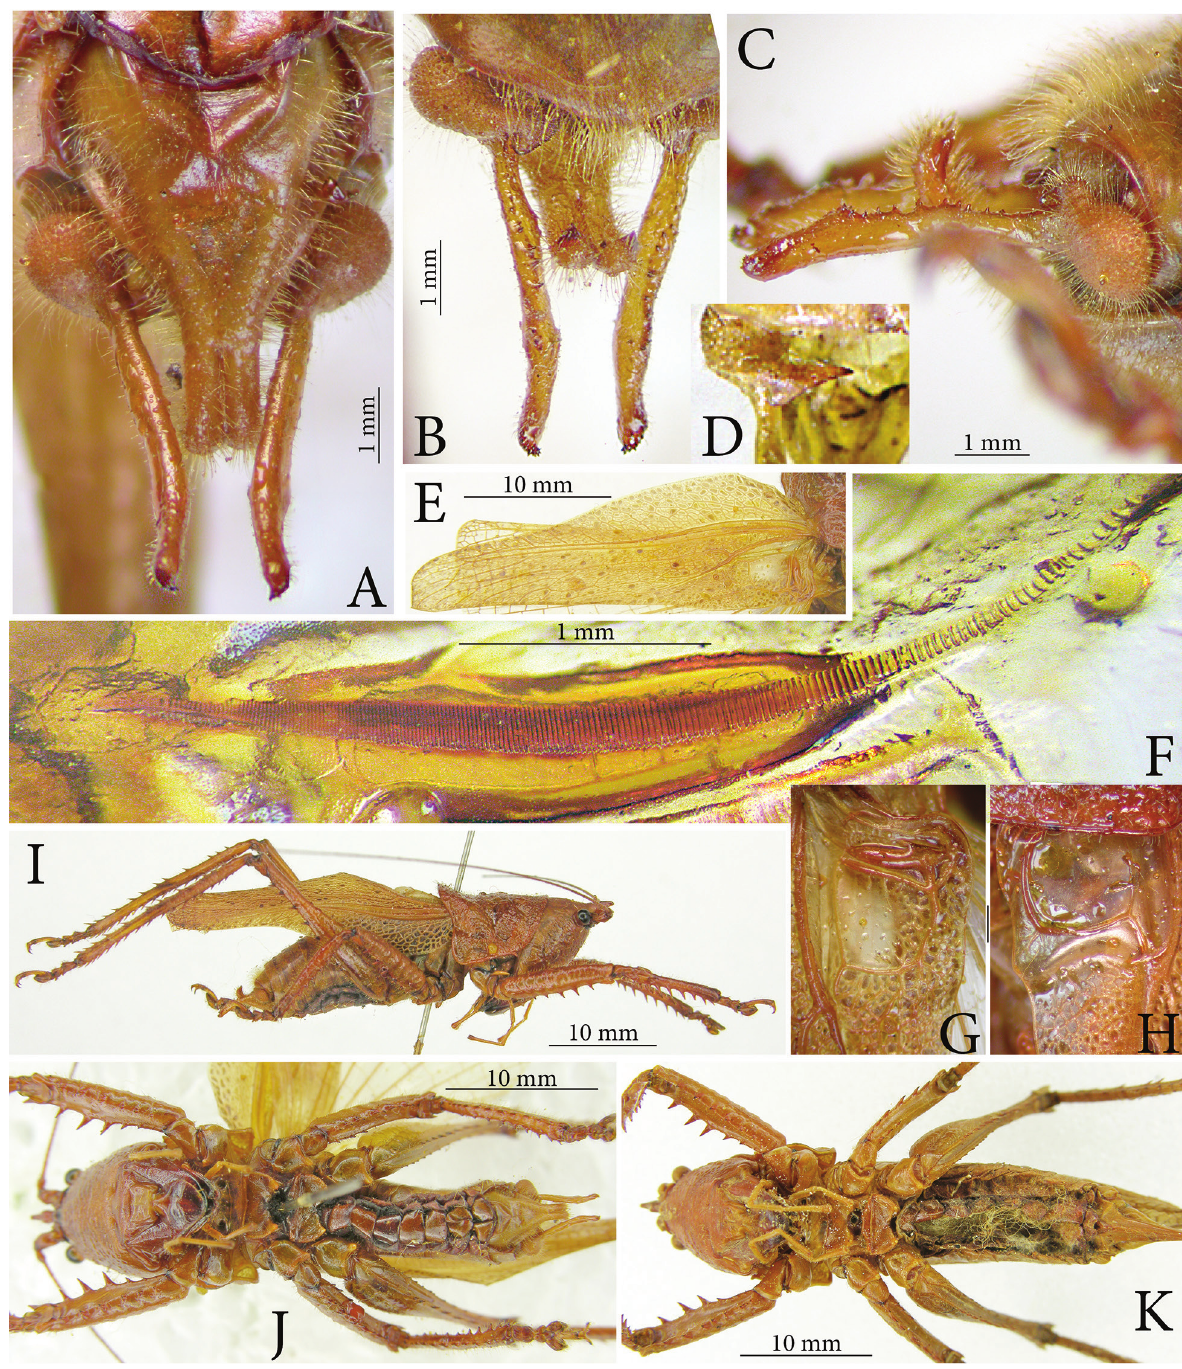
Figure 1. Peracca ( Robustacca ) robustus (Karny, 1923) comb. nov. male from Ampang ( A–C, E–J ), male from SE Pahang ( D ), and female holotype ( K ): A–C male subgenital plate and cerci in ventral ( A ), dorsal ( B ) and lateral view ( C ); D basal area of male left cercus in medio-dorsal view; E left tegmen, F stridulatory file on underside of left tegmen; G, H stridulatory area of left ( G ) and right tegmen ( H ) in dorsal view; I habitus lateral view; J, K ventral view of body and femora of male ( J ) and female ( K